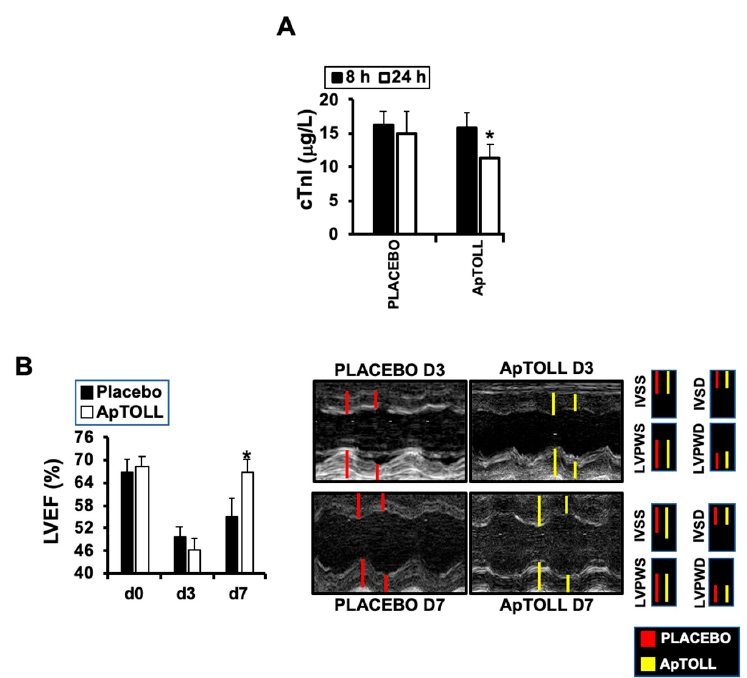
Figure 1. ( A ) Cardiac Troponin I (cTnI) levels in plasma collected from pigs treated with 0.078 mg/kg ApTOLL or Placebo at 8 and 24 h after ischemia/reperfusion (IR) (N = 10/group, mean ± SD * p < 0.002 ApTOLL). ( B ) Left ventricle ejection fraction levels detected by cardiac ultrasound at the times indicated. Representative M-Mode images from Placebo and ApTOLL treated animals, in which end diastolic and systolic thickness of the interventricular septum thickness (IVS) and left-ventricle posterior wall thickness (LVPW) are represented (N = 10/group (d0), N = 9 ApTOLL/8 Placebo (d3, and d7). Mean ± SD * p < 0.001 ApTOLL vs. Placebo).